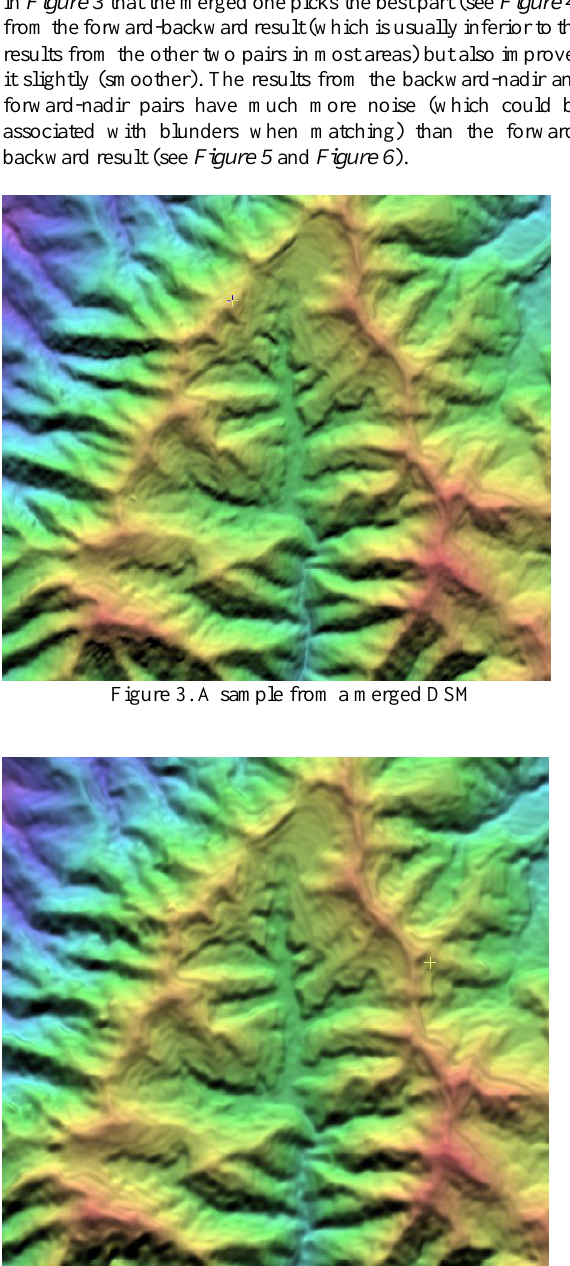
Figure 4. A sample from the forward-backward DSM.